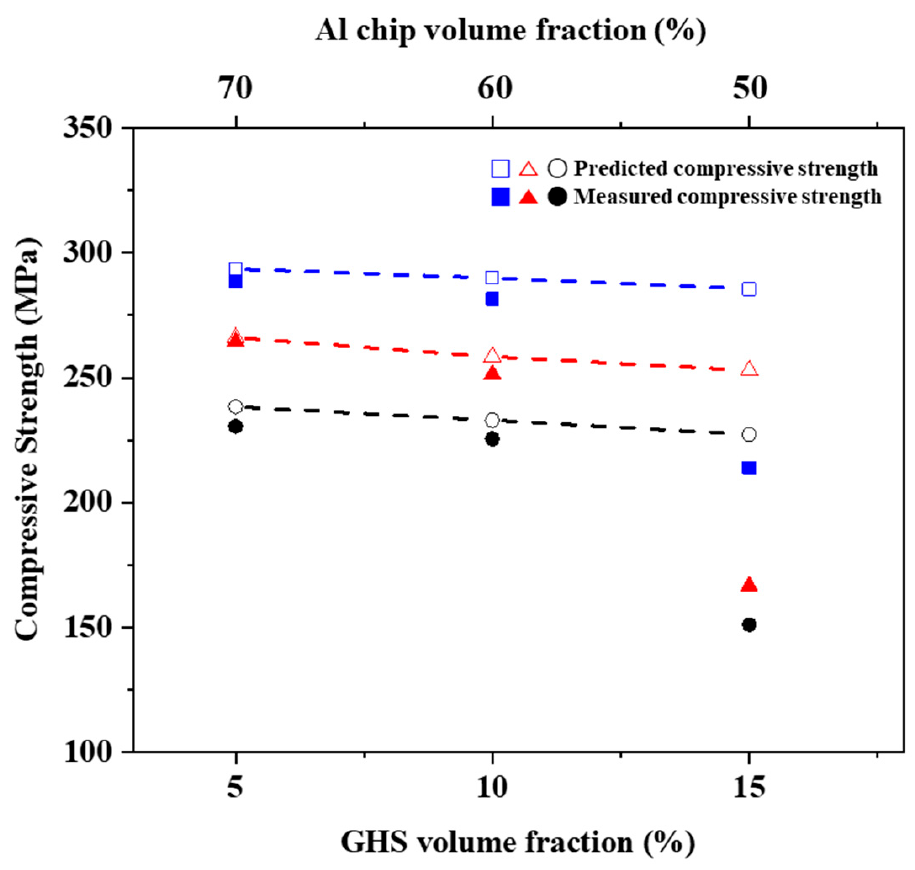
Figure 12. Predicted (dotted lines) and measured (dots) compressive strengths of AlG foam with different GHS contents.